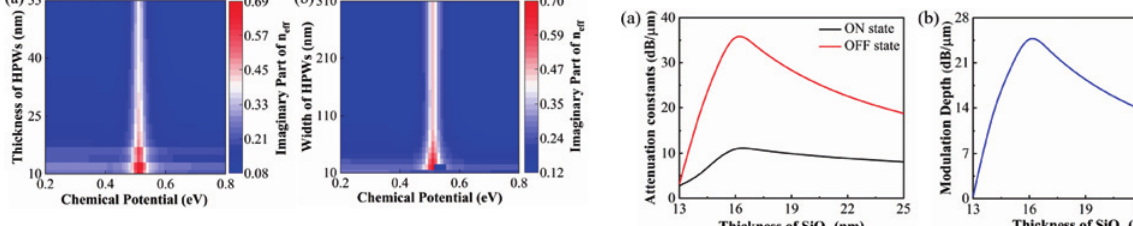
Figure 7: (a) Changes of α at ‘ ON ’ and ‘ OFF ’ states, and (b) modulation depth with the increase of t 2